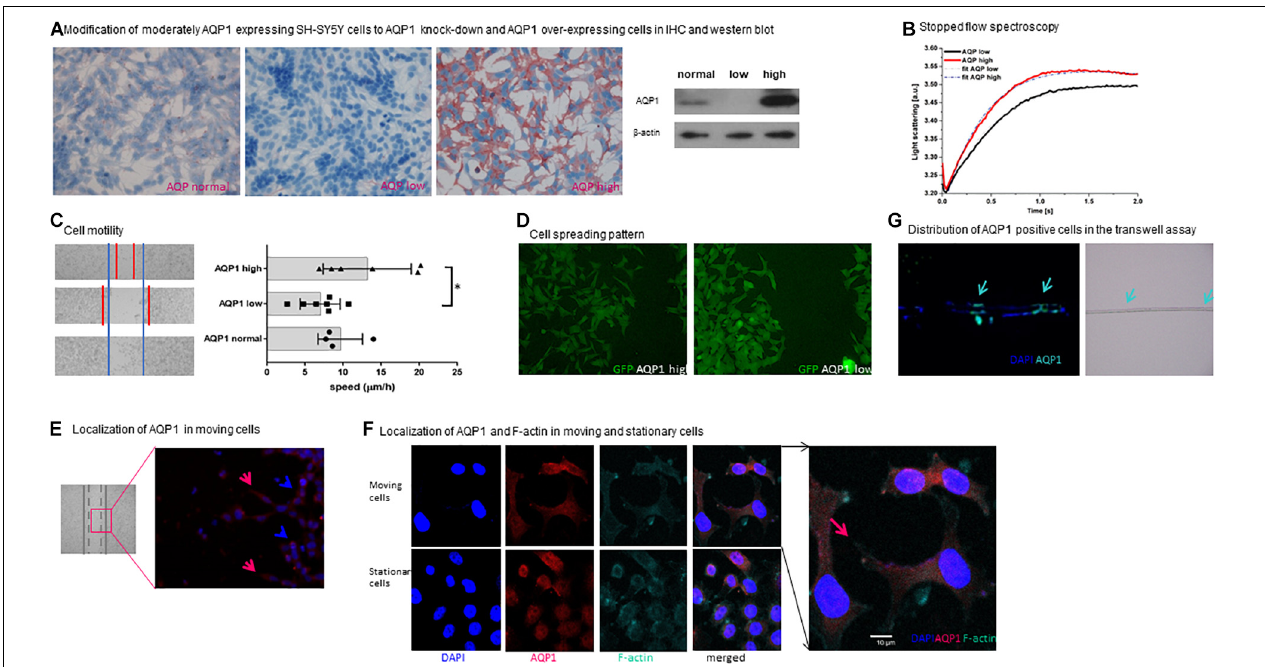
FIGURE 2 | Functional properties of AQP1 expressing cells . (A) Modification of moderately AQP1 expressing SH-SY5Y cells to AQP1 knock-down and AQP1 over-expressing cells in IHC and western blot. Modification of SH-SY5Y cells results in an AQP1 knock-down (AQP1 low) and over-expressing cell line (AQP1 high). This was confirmed by immunohistochemistry (red staining of AQP1) and by western blot. Staining was performed in duplicate and repeated, blotting was performed twice. (B) Stopped flow spectroscopy. The kinetics of the initial increase of the curves confirm a faster reaction of AQP1 high cells against AQP1 low cells to the osmotic stimulus due to increased water channel function. The consecutive decrease of the curves is due to volume regulation mechanisms of the cells, again faster in the AQP1 high cells compared to the AQP1 low cells. This results in a higher rate constant for AQP1 high cells than AQP1 low cells: k APQ1high = 3.27 ± 0.033 s − 1 and k APQ1low = 2.02 ± 0.007 s − 1 , respectively. Experimental curves are represented as the average of three series, each with a minimum of ten injections. Details regarding the analysis are given in the section “Materials and Methods”. (C) Cell motility. The left panel shows representative images of the migration progress of cells 24 h after the defined scratch in the wound healing assay using SH-SY5Y neuroblastoma cells. The blue lines represent the set border of the regular cell line (lower image), the red markings the margins of the AQP1 low (middle image) and AQP1 high cell (upper image) lines in bright field microscopy. The right panel depicts the speed of closure of the gap in µ m/h, confirming the visual impression that closure of the gap by AQP1 high cells is increased and reduced in the AQP1 knock-down. Experiments were performed in quadruplicate and repeated twice. One-way Anova was performed followed by Tukey multiple comparison test using GraphPad Prism7. Normal distribution was confirmed. The error bars represent one standard deviation. (D) Cell spreading pattern. AQP1 high neuroblastoma cells (upper panel) show a distinct morphological pattern when closing the wound. They are more spread out and form more lamellipodia compared to AQP1 low neuroblastoma cells (lower panel). GFP expression of cells is unspecific and due to transfection. Experiment was performed in quadruplicate and repeated twice. (E) Localization of AQP1 in moving cells. Immunofluorescence staining of AQP1 (red) and cell nuclei (DAPI blue) shows that in the area in which cells migrate toward the gap in the wound healing assay, AQP1 is located in the forward moving part of the cell (marked by red arrows) and in the lamellipodia. Cells, that do not move (marked by blue arrow), have a round shape and AQP1 is localized around the nuclei. Staining was performed in duplicate and repeated twice. (F) Localization of AQP1 and F-actin in moving cells. In confocal fluorescence microscopy after AQP1 and F-actin staining AQP1 and actin are located in the lamellipodia (marked by red arrow), giving evidence of the cytoskeletal changes of the migrating SH-SY5Y neuroblastoma cells. Staining was performed in quadruplicate and performed twice. (G) Distribution of AQP1 positive cells in the transwell assay. Examination of the 8 µ m pore membrane (right panel, pores are marked by arrows) of a transwell migration assay with a FCS gradient using SH-SY5Y cells captures AQP1 (green) expressing cells in immunofluorescence staining gathered around the pores (marked with arrows) on both sides of the membrane in the progress of migrating through the pores. AQP1 negative cells (blue, only positive for DAPI nuclei staining) are localized in other areas of the membrane. This was performed once to depict cell transit through